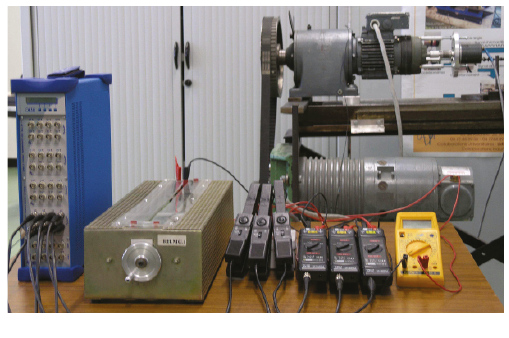
Figure 16: Test rig.